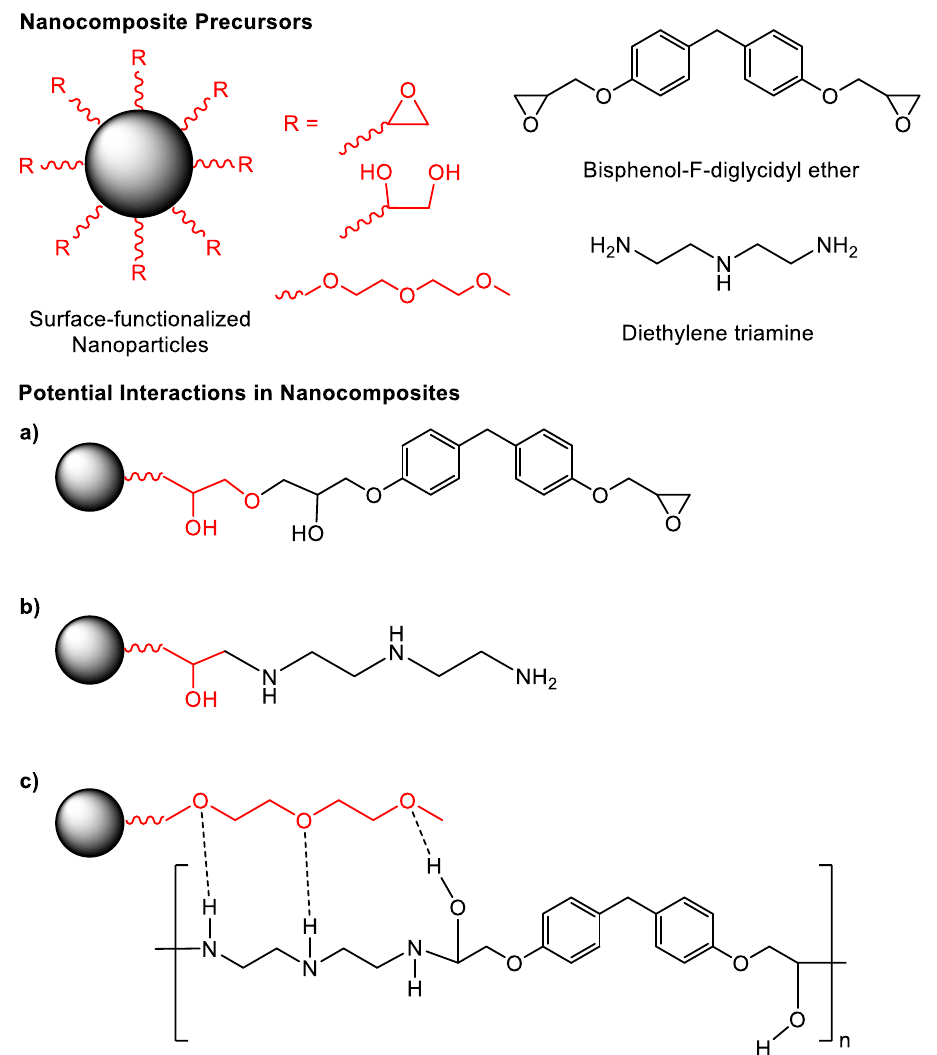
Figure 2. Potential interactions between surface-functionalized nanoparticles and epoxy resin in nanocomposites: ( a ) reactions between hydroxy-groups located at the nanoparticle surfaces with epoxides of the resin mixture, ( b ) epoxide groups from the nanoparticle surface are attacked by the hardener molecules, ( c ) hydrogen-bond formation between epoxy resin and ethylene oxide moieties on particle surface.